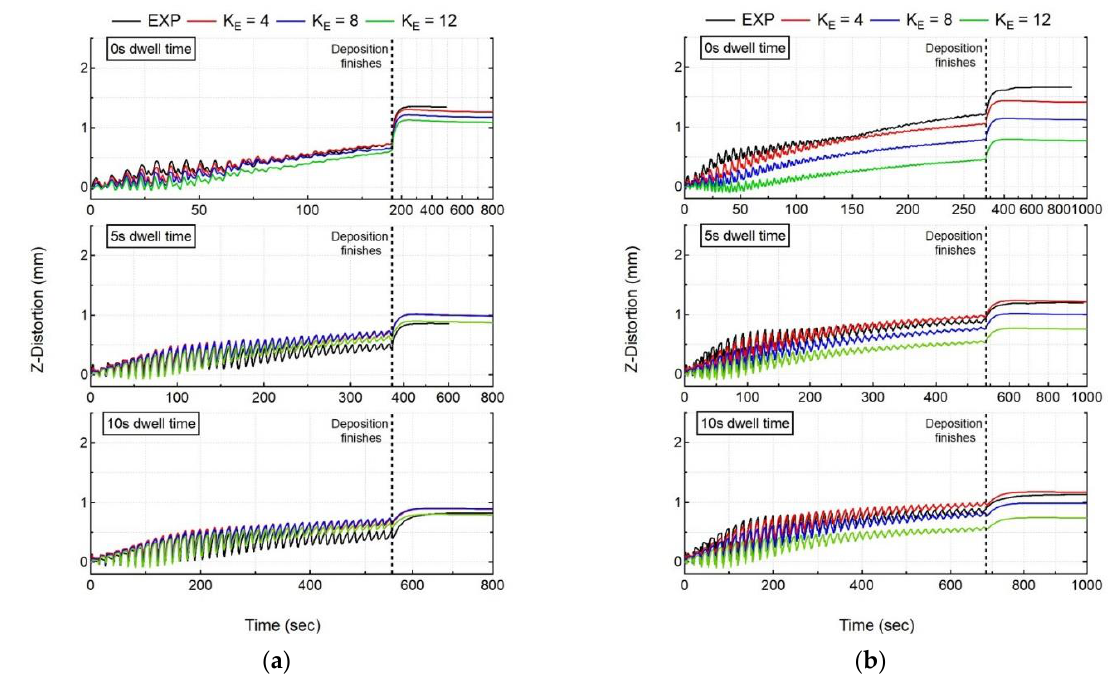
Figure 12. Comparison of numerical results using the elongated ellipsoid with recorded in situ distortion accumulation of LDS for all cases ( a ) single-bead wall, ( b ) double-bead wall.